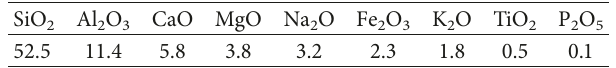
Table 4: Chemical composition of red sandstone